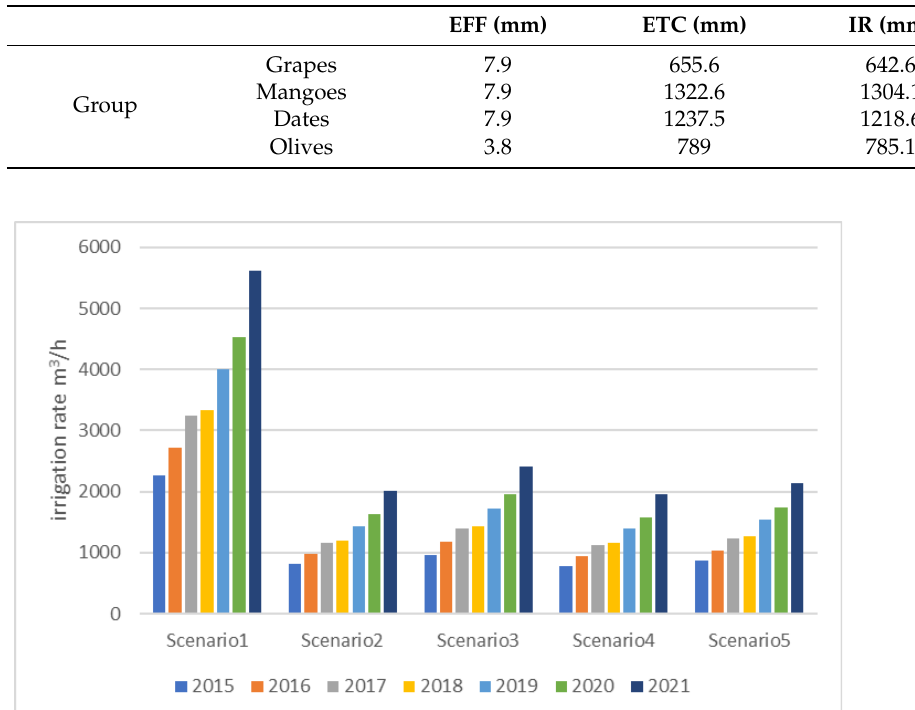
Figure 9. The consumption rate recorded by each proposed scenario. Table 2. The effective rain (EFF), potential crop evapotranspiration (ETC), and irrigation required (IR), for each crop